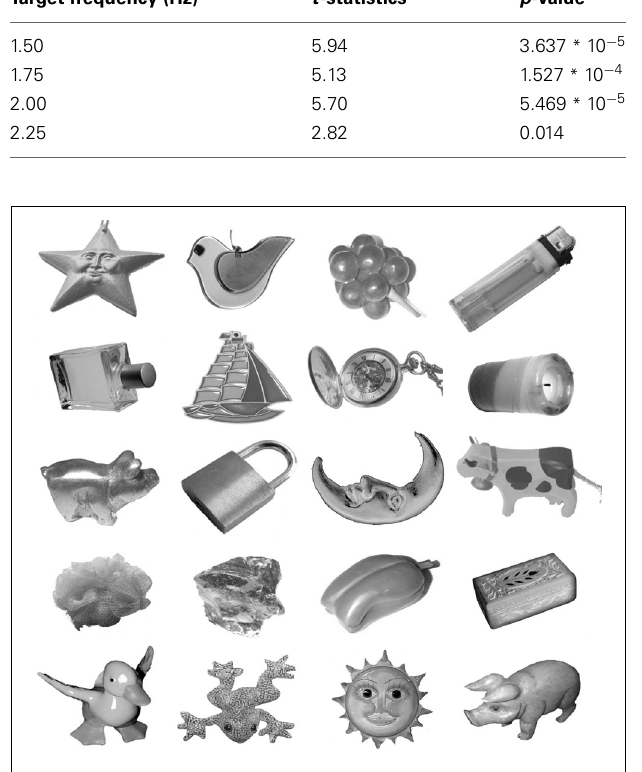
FIGURE A3 | Average difference in 2Hz power between hits and misses as a function of time around target onset per size of the sliding window in the FFT power spectrum